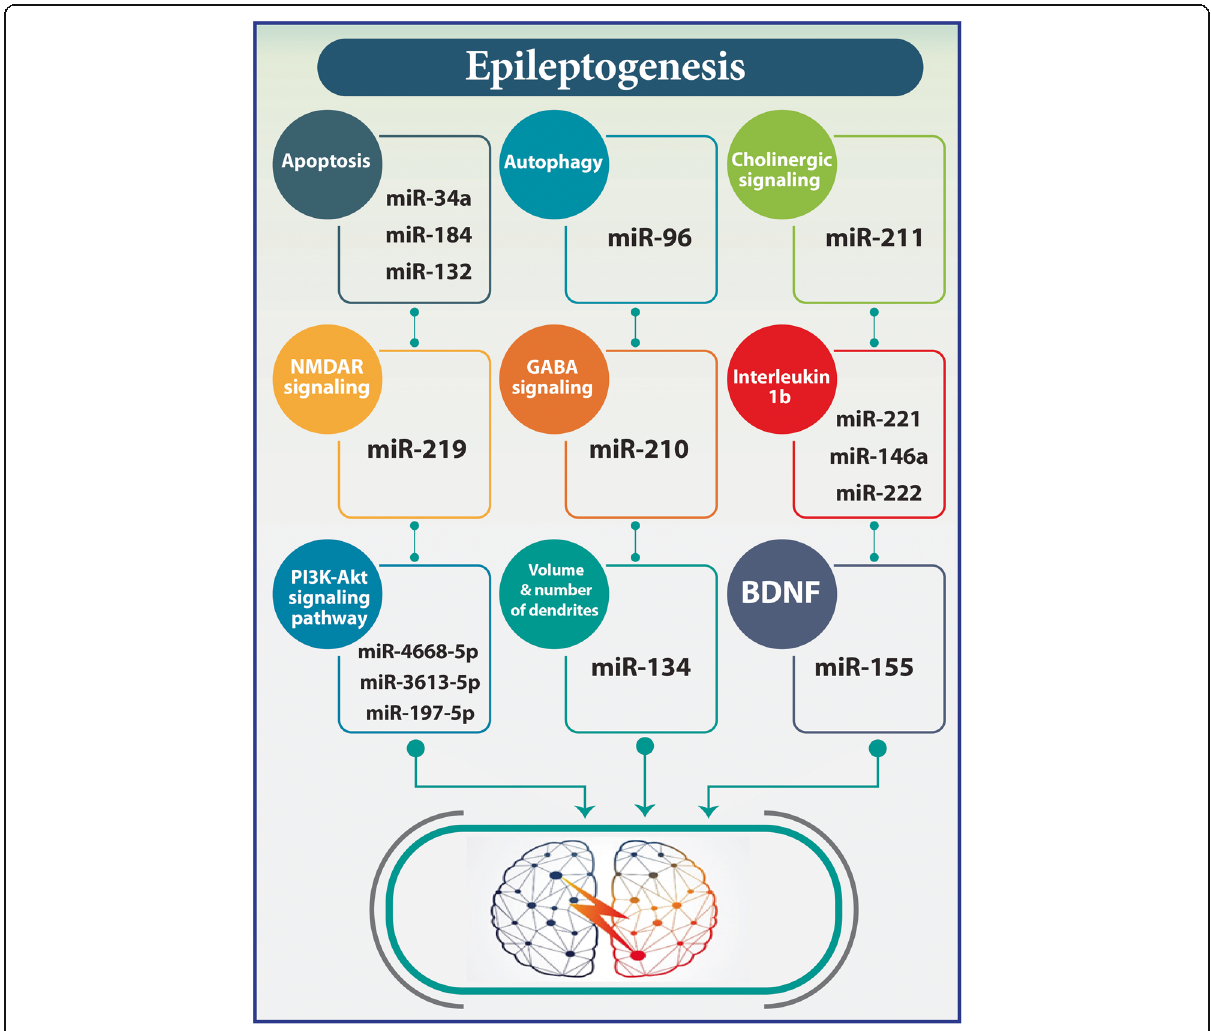
Fig. 4 Micro RNAs dysregulation in epileptogenesis. miRNAs dysregulation were linked to the mechanisms of epileptogenesis through regulating ion channels, neuroinflammation, synaptic plasticity, and neuronal apoptosis. GABA: γ -aminobutyric acid, NMDA: N-methyl-d-aspartate, PI3K-Akt: The phosphatidylinositol 3-kinase/protein kinase B, BDNF: Brain-derived neurotrophic